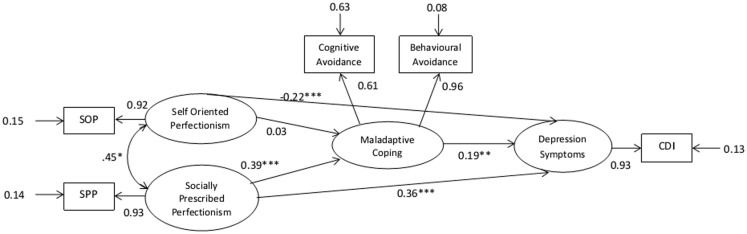
Gender controlled saturated structural equation model at pre-test. N = 541. *p < 0.05, two-tailed; **p < 0.01, two-tailed; ***p < 0.001.